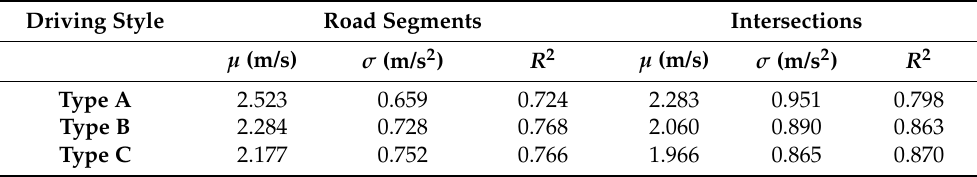
Table 7. The speed distribution fitting parameters of different types of